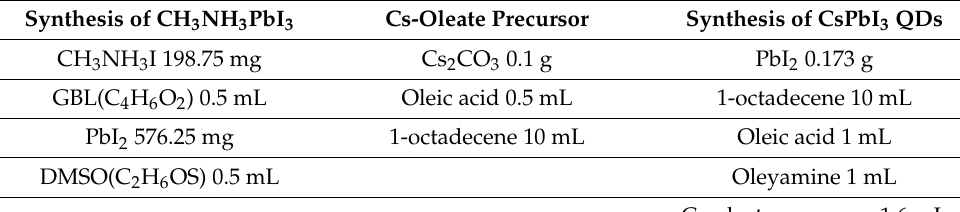
Table 1. Preparation parameters of CH 3 NH 3 PbI 3 , Cs-oleate precursor, and CsPbI 3